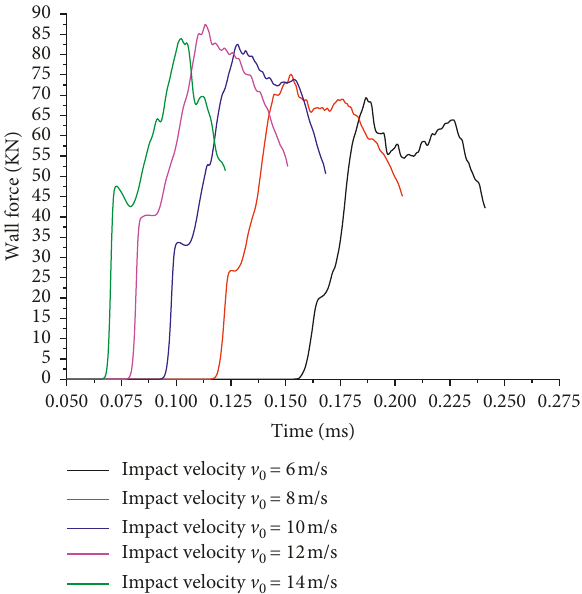
Figure 16: Wall forces for HCR as functions of the time in positive y -load modes under different impact velocities.